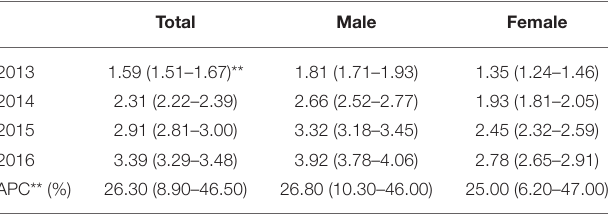
TABLE 4 | Annual age-standardized prevalence rate of Crohn’s disease among urban employees in 23 provinces (municipalities, autonomous regions) of China from 2013 to 2016 (per 100,000 persons) * .